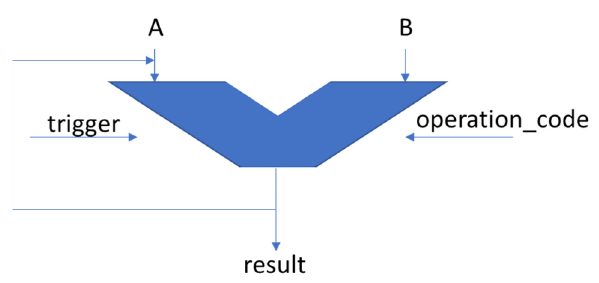
Figure 3. The DUT used as an example in the current paper.